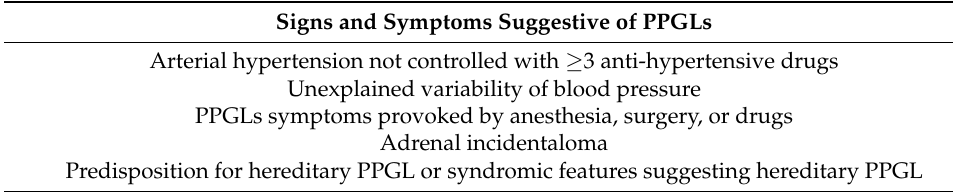
Table 2. Indications for biochemical testing for PPGL. Signs and Symptoms Suggestive of PPGLs Arterial hypertension not controlled with ≥ 3 anti-hypertensive